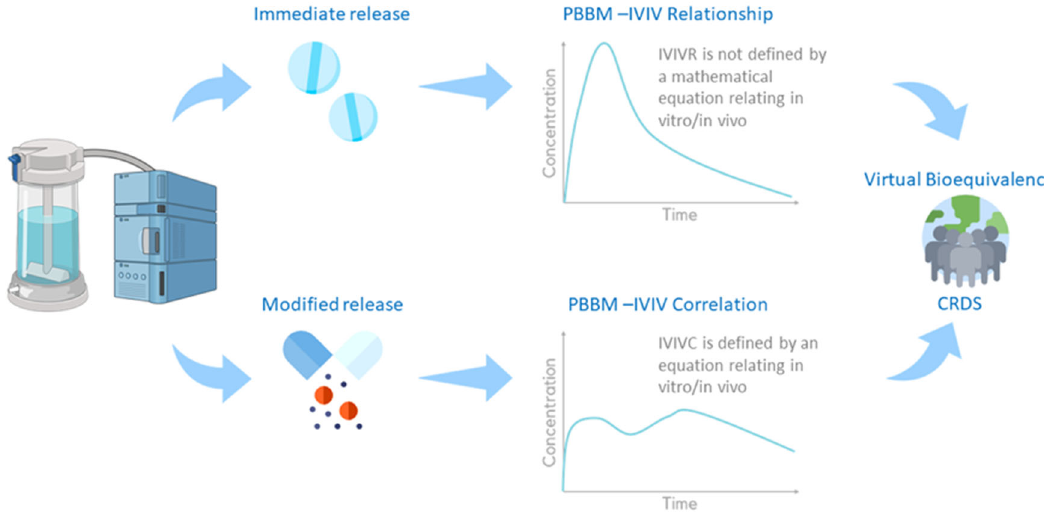
Figure 3. Framework for virtual bioequivalence and CRDSs.